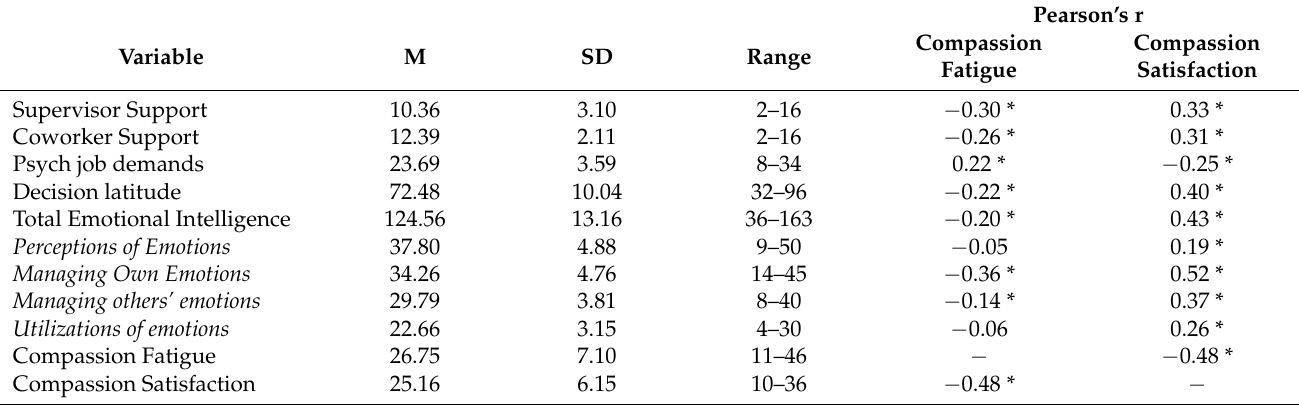
Table 3. Means, Standard Deviations, and Pearson Correlations of Proposed Antecedents of Compassion Fatigue and Compassion